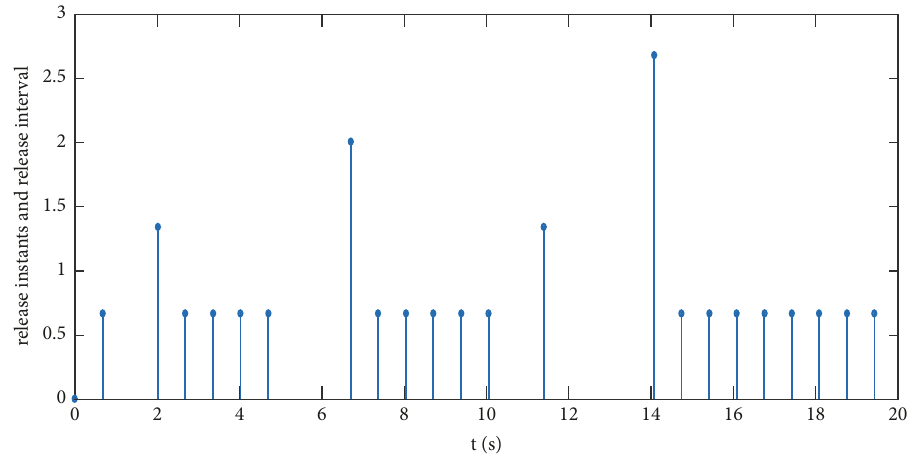
Figure 4: Static event-based release interval and release instants, h=0.12.